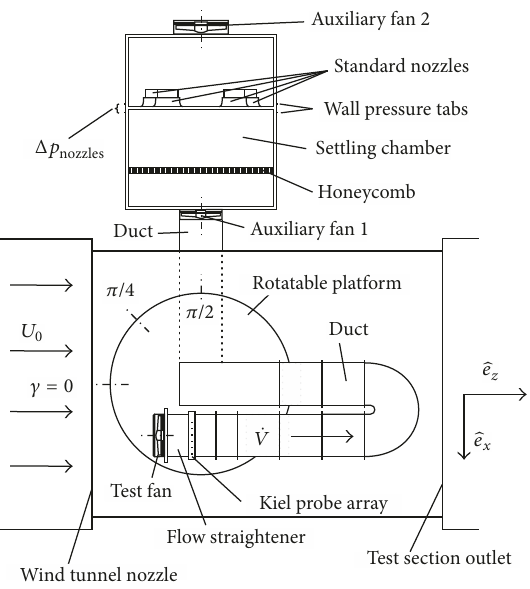
Figure 3: Wind tunnel fan test rig.